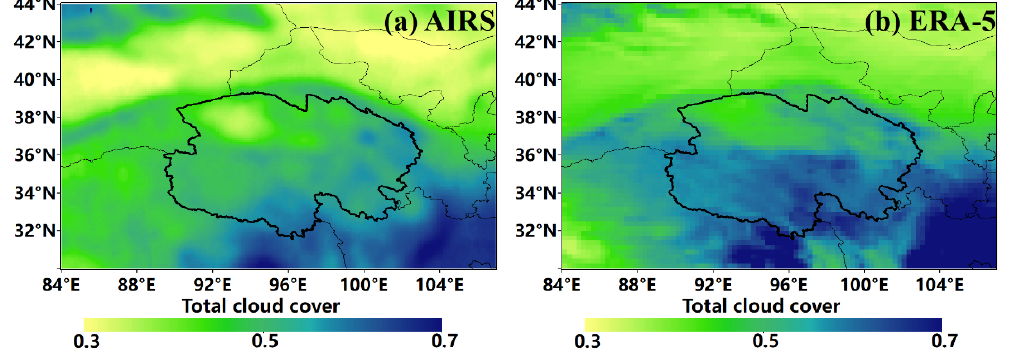
Figure A1. Multi-year mean total cloud cover in the study area. ( a ) AIRS data. ( b ) ERA-5 data.